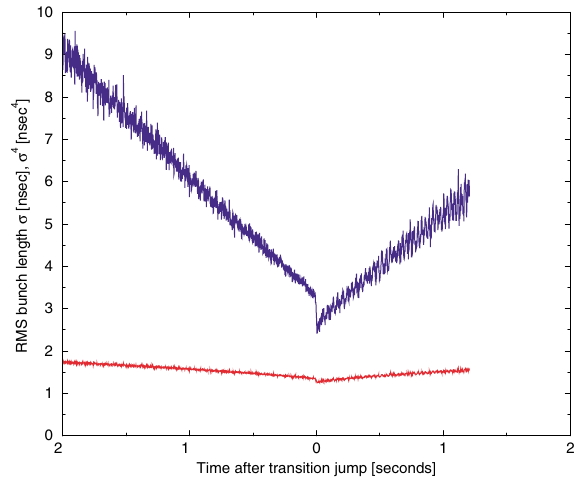
FIG. 7. (Color) Measured rms bunch length # corresponding fourth power # 4 timing of the rf phase flip with respect to the (cid:4) jump. No longitudinal quadrupole oscillation is induced by the transition jump, indicating optimized timing.